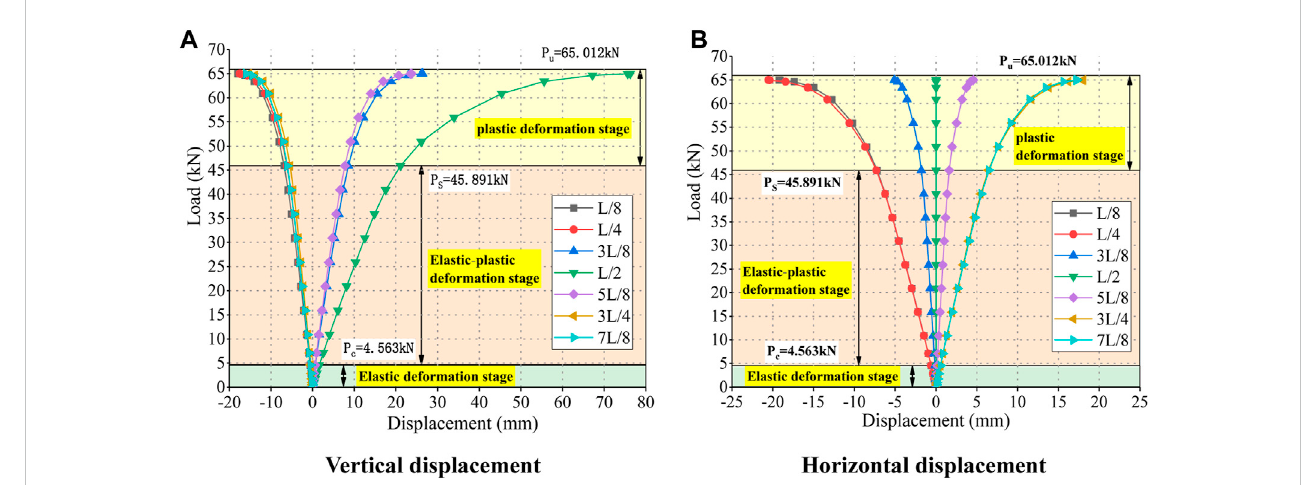
FIGURE 9 A-1 arch of the load – displacement curve: (A) Vertical displacement; (B) Horizontal